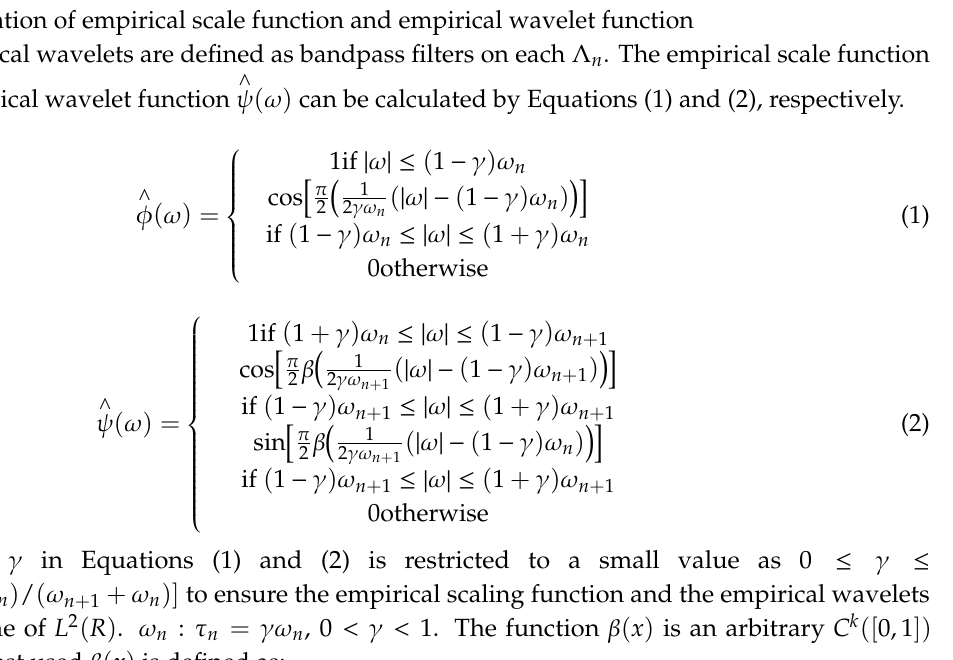
Figure 1. Partitioning of the Fourier axis.